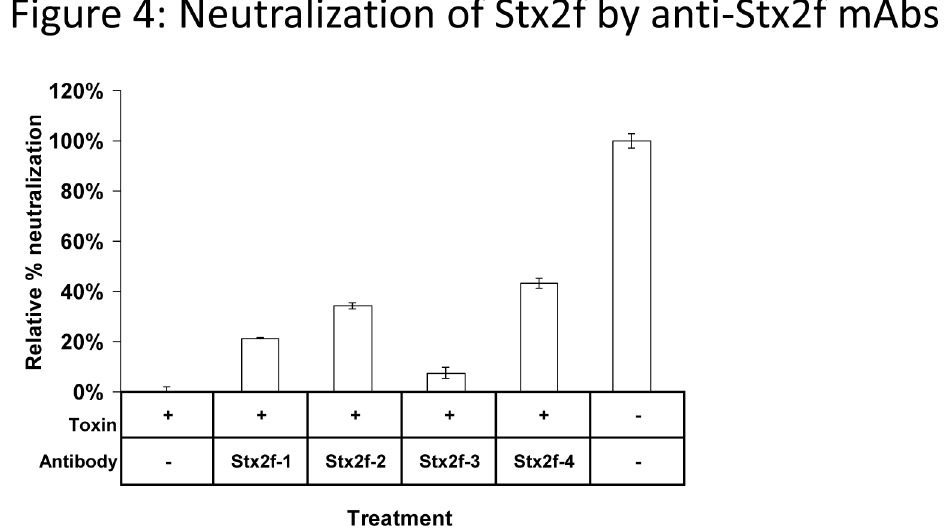
Figure 4. Neutralization of Stx2f by anti-Stx2f mAbs. Stx2f (5 ng/mL) was pre-incubated with antibody (100 µg/mL) for 1 hour at RT. This mixture was then incubated with Vero cells for 1 hour at 4°C. The media was removed and new media was added. Cell viability was measured using the CellTitre-Glo reagent. Data shown represent the mean ± SD of three replicates from one representative experiment. This experiment was conducted three times with similar